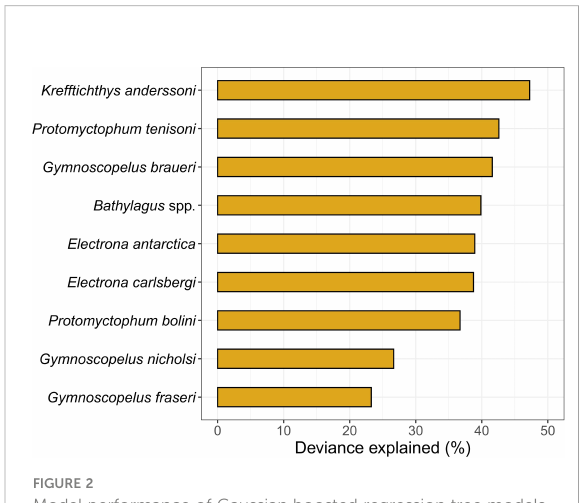
FIGURE 2 Model performance of Gaussian boosted regression tree models measured as the percent deviance explained, a measure of goodness-of- fi t, for nine taxa from ten-fold cross